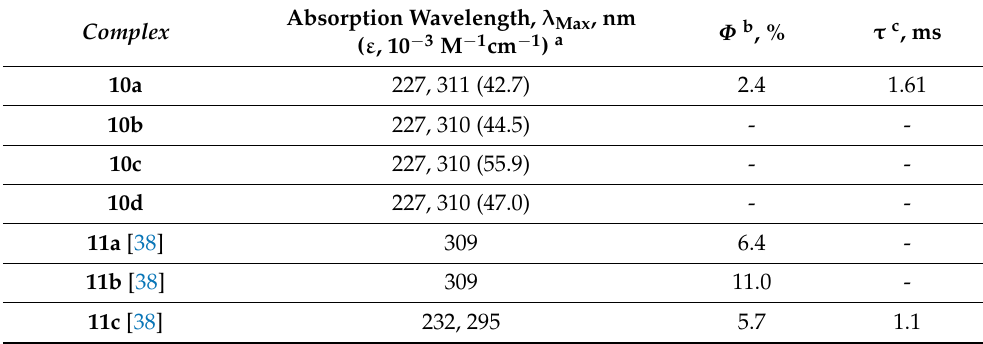
Figure 6. The structure of previously obtained europium complexes. Table 1 . Photophysical data for the complexes 10a–d compared to the previously obtained com- plexes 11a–c .